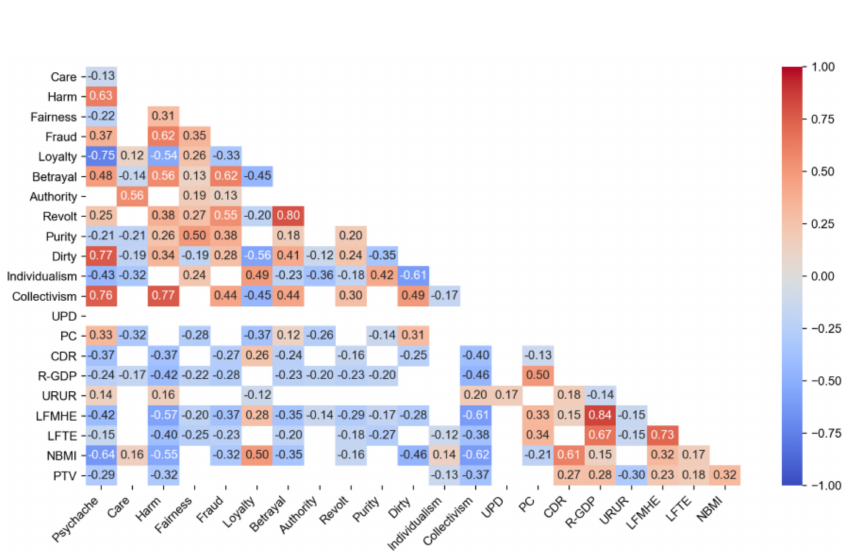
Figure 1. Variables correlation heat map. Null value means the correlation is not significant. Abbreviations: UPD, Urban population density; PC, Passenger capacity; CDR, Crude divorce rate; R-GDP, Regional gross domestic product; URUR, Urban registered unemployment rate; LFMHE, Local financial, medical and health expenditure; LFTE, Local fiscal transportation expenditure; NBMI, Number of beds in medical institutions; PTV, Public transportation